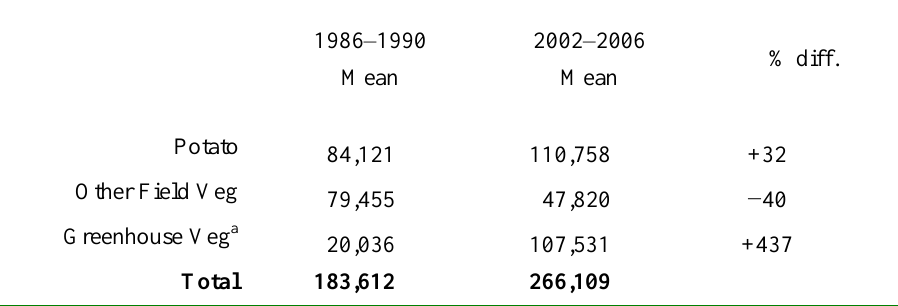
Table 4. Summary Statistics, Changes in BC Vegetable Production,